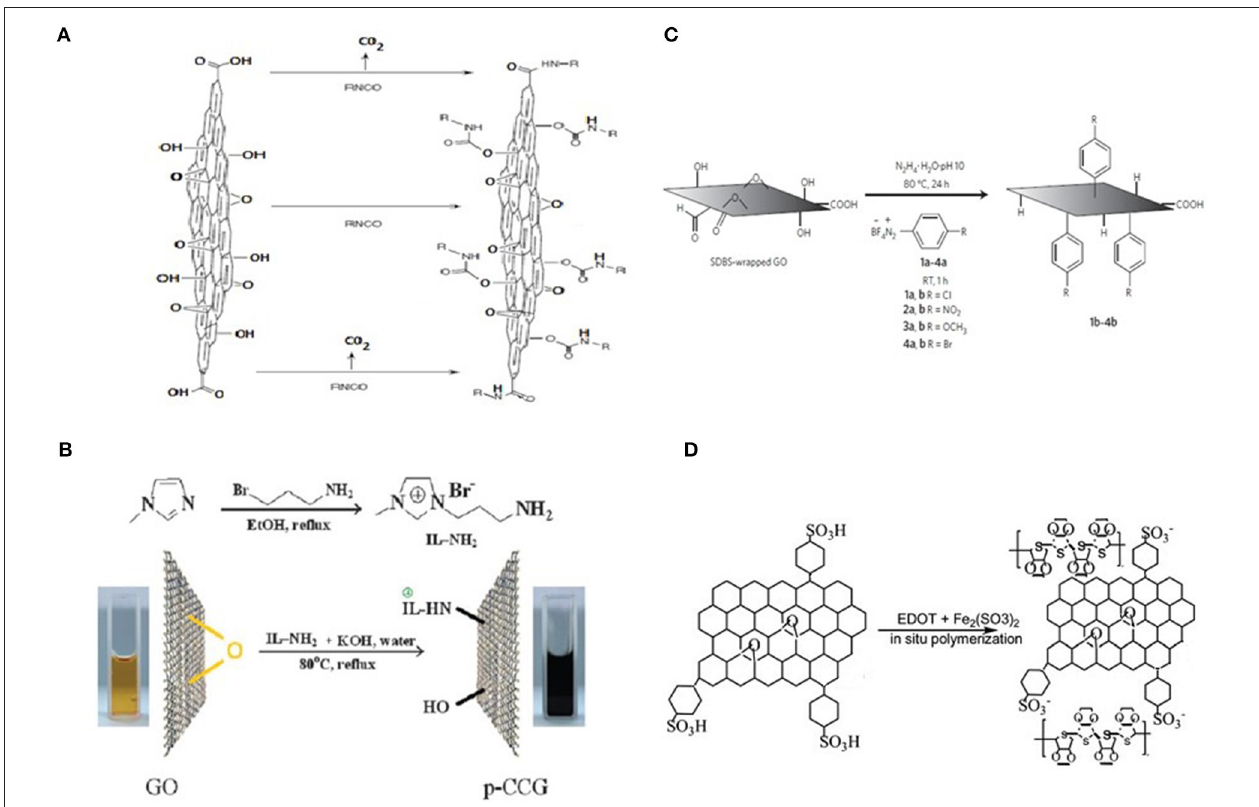
FIGURE 3 | Chemical modification of GO and rGO. (A) Isocyanate treatment of GO where organic isocyanates react with the hydroxyl (central arrow) and carboxyl groups (top and bottom arrows) of GO sheets to form carbamate and amide functionalities, respectively. Accordingly to Stankovich et al. [ 38] Copyright 2006, Elsevier, Inc. (B) Covalent functionalization of epoxy groups of GO by an ionic liquid. Adopted with permission from Yang et al. [ 39] Copyright 2009, RSC. (C) Diazonium functionalization of surfactant-wrapped chemically converted graphene sheets. GO was treated by sodium dodecylbenzenesulfonate (SDBS) surfactant. Adopted with permission from Lomeda et al. [ 40]. Copyright 2008 ACS. (D) Poly(3,4-ethyldioxythiophene)[PEDOT]/sulphonated graphene nanocomposite Accordingly to Xu et al.